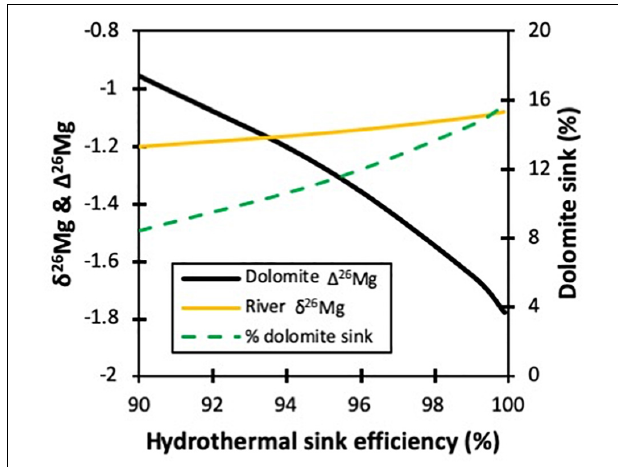
FIGURE 7 | Models on a steady-state modern seawater Mg budget, assuming that the hydrothermal sink is not fully efficient, and causes isotope fractionation as observed in our samples. See text for details.